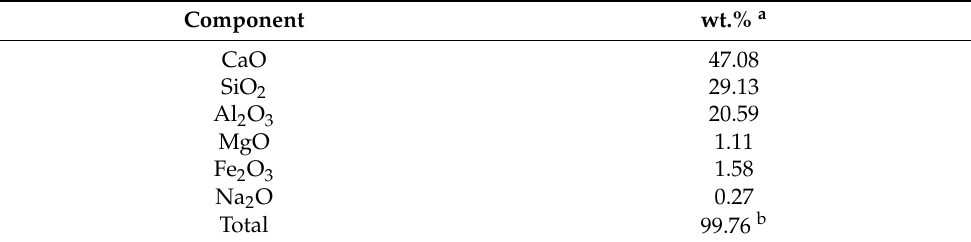
Table 1. Chemical components of blast furnace slag